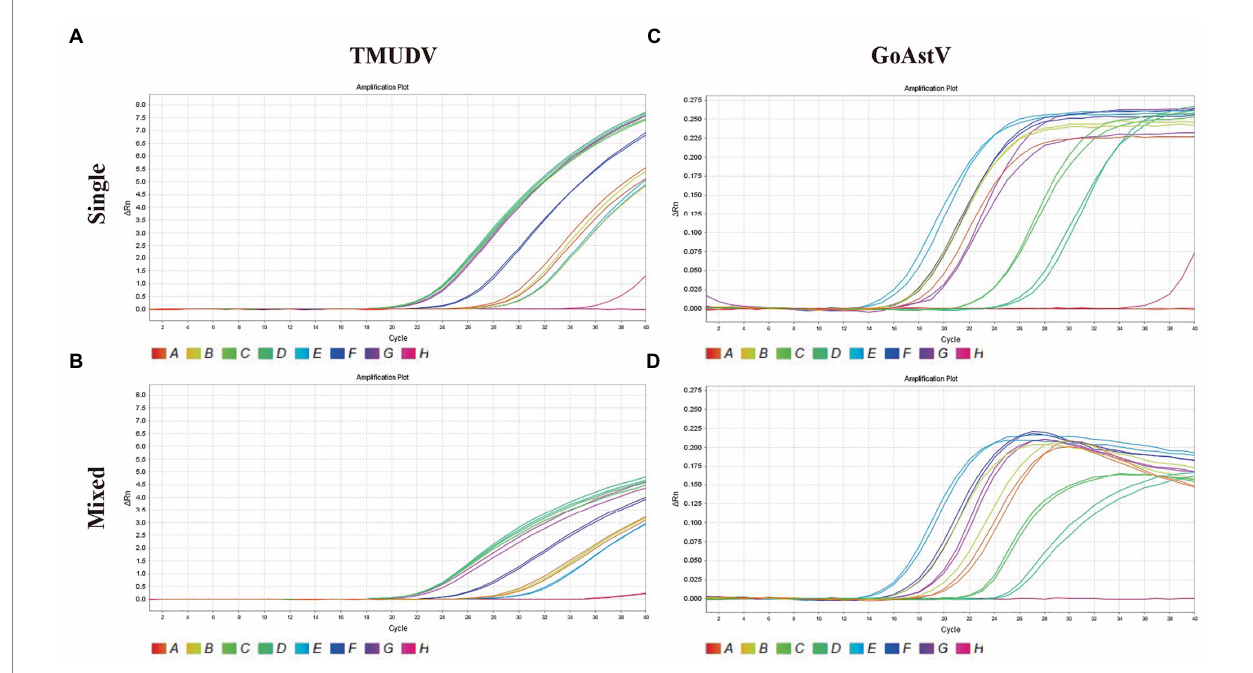
FIGURE 4 Application of duplex TaqMan qPCR for detection of Tembusu virus ( A , single positive samples; B , mixed positive samples) and goose astrovirus ( C , single positive samples; D , mixed positive samples) in clinical mixed RT-PCR-positive